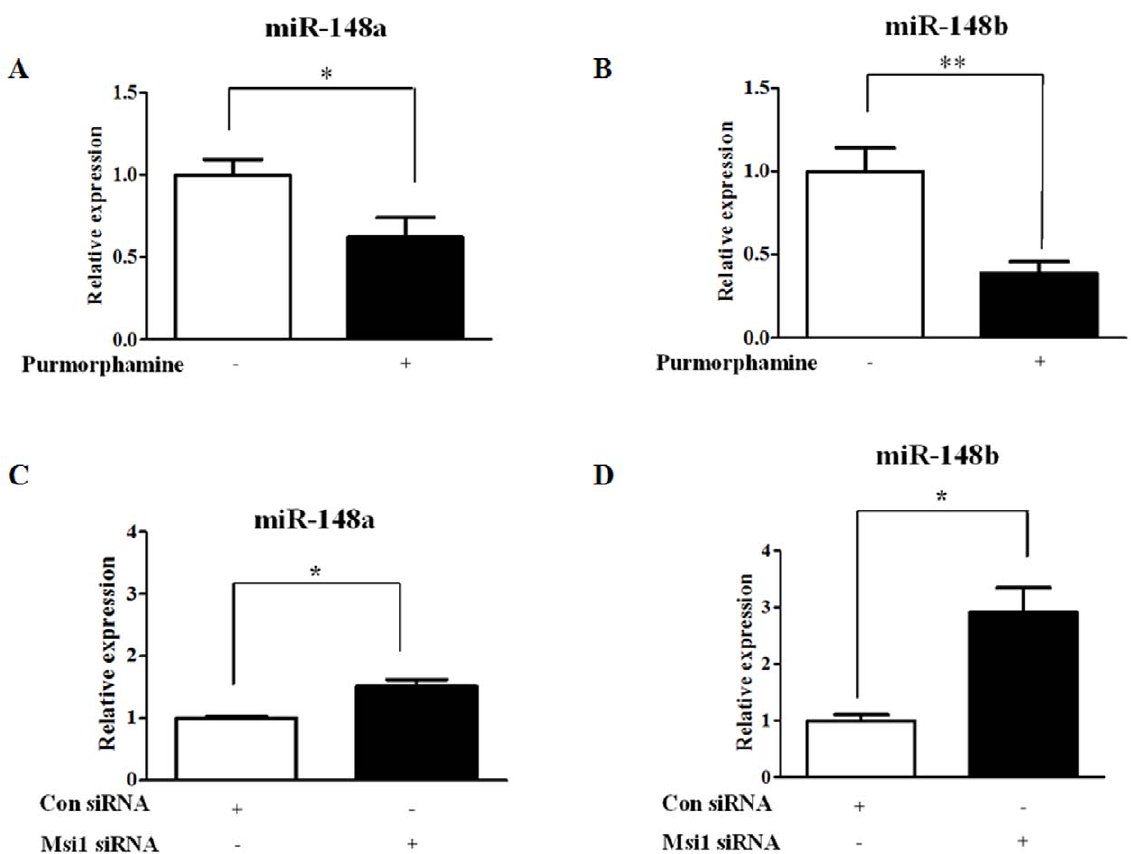
Figure 7. The effects of purmorphamine and Msi1 knockdown on miR-148a and miR-148b expression. hUCB-MSCs were treated with 4 m M purmorphamine for 3 days or transfected with 50 nM Msi1 siRNA, and then, the expression profiles of the miRNAs were analyzed by real-time PCR. The expression levels of miR-148a ( A ) and miR-148b ( B ) were decreased by purmorphamine treatment. The transfection of 50 nM Msi1 siRNA increased the expression levels of miR-148a ( C ) and miR-148b ( D ). The results are shown as the mean 6 SD from three independent experiments. * P , 0.05, ** P , 0.01, and *** P , 0.001.